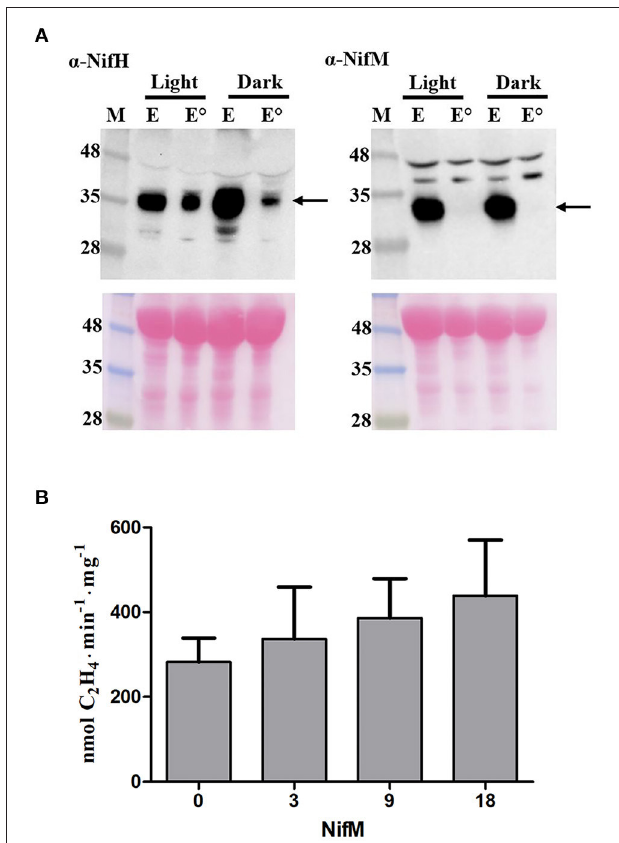
FIGURE 4 | NifM does not inhibit NifH activity. (A ) Immunoblot analysis of NifH and NifM levels in NifH-enriched samples (E) prepared from leaves harvested under light (Light) or darkness (Dark) with ( ◦ ) or without heat treatment. M, molecular mass markers (kDa). Arrows indicate positions of NifH and NifM in the membrane. Ponceau staining of membrane is shown at the bottom as control of protein loading and transfer. (B ) ARA using a 9:1 molar ratio of NifH:NifDK in the presence of increasing amounts of NifM (values in the x-axis indicate the ratio of NifM over NifDK). Average activities ± SD ( n = 3) are